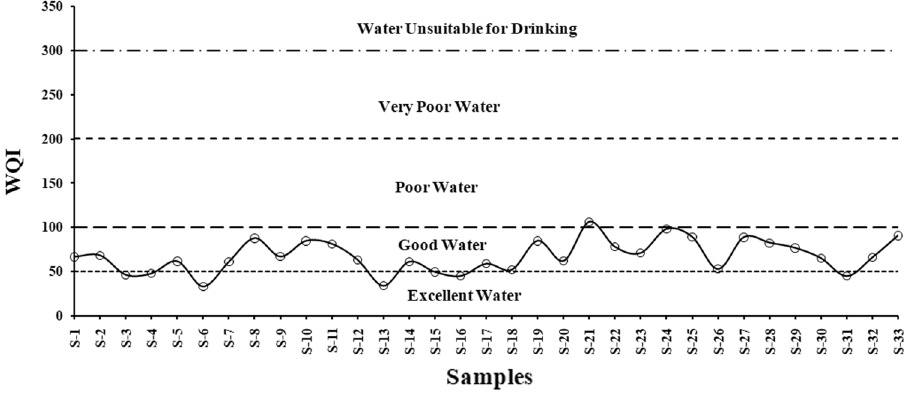
Fig. 2 Categorisation of groundwater samples based on WQI w.r.t WHO